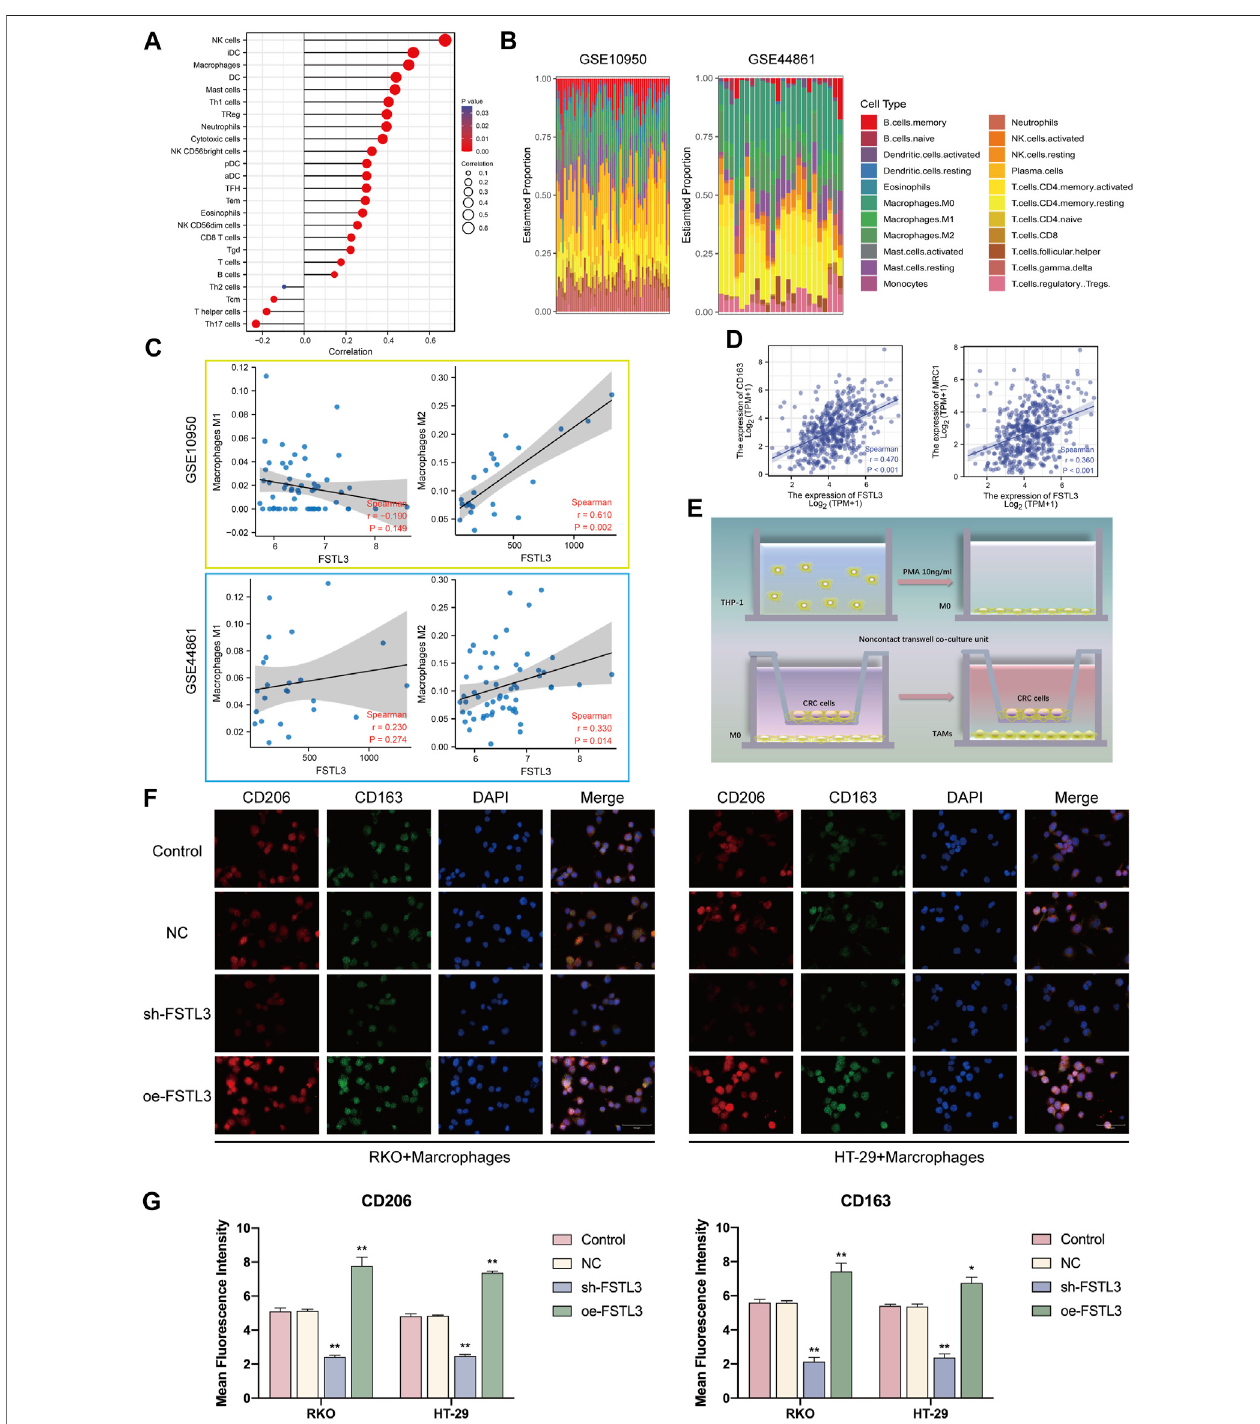
FIGURE 6 | Immune landscape of the colorectal cancer (CRC) patients with the different expression levels of FSTL3 and the relationship between the FSTL3 expression and the abundance of M2 tumor-associated macrophage in fi ltration. (A) Spearman correlation between FSTL3 and 24 types of immune cells; positive correlation, red lollipop, and negative correlation, blue lollipop. (B) Proportion of22 types of Tumor-initiating cells (TICs) in the CRC tumor samples based on GSE10950 and GSE44861. (C) Correlation of the FSTL3 expression levels with macrophage abundance based on GSE10950 and GSE44861. (D) Correlation of the FSTL3 expression levels with M2 macrophage markers. (E) Schematic diagram for the tumor – macrophage cell co-culture. (F) Immuno fl uorescence staining for CD206 (red) and CD163 (green). (G) Immuno fl uorescence intensities are expressed as mean intensity ± SD. * p < 0.05, ** p < 0.01, *** p < 0.001.